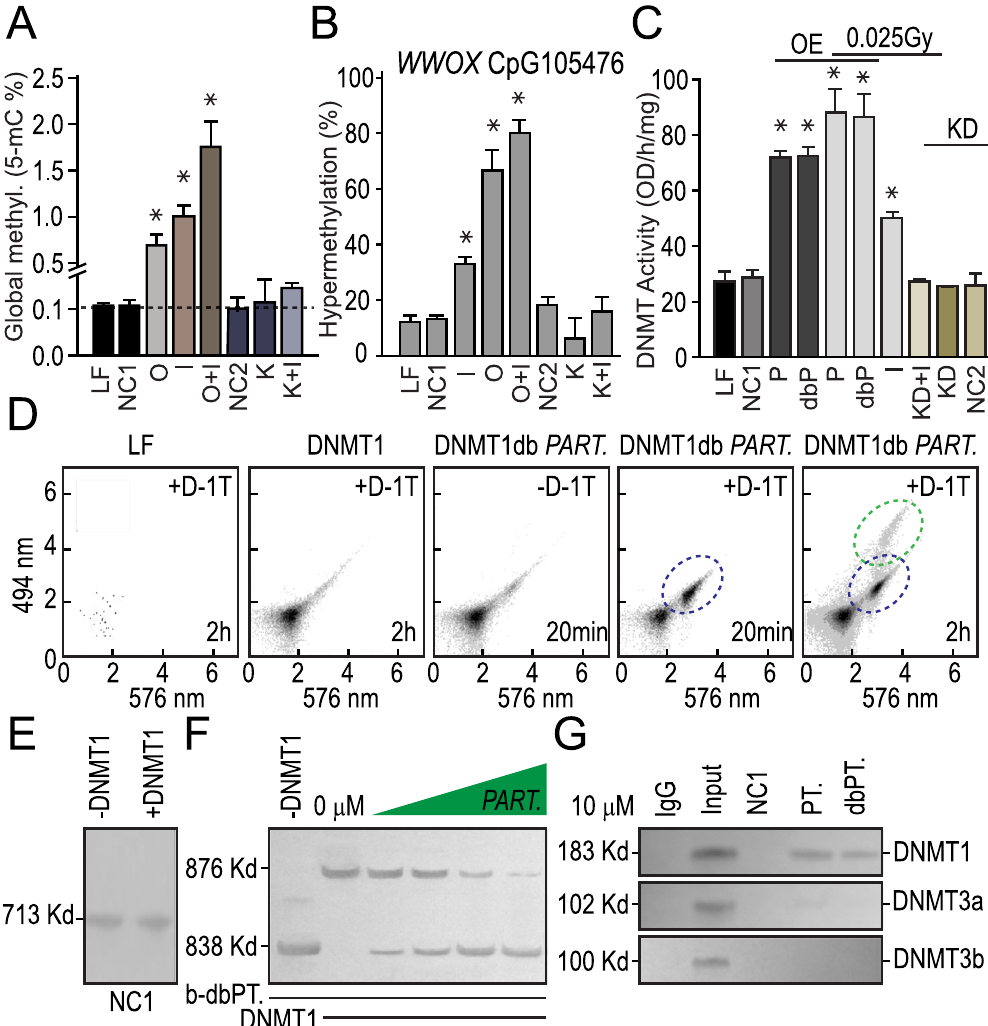
Figure 4. PARTICLE is implicated in global methylome enhancement, WWOX CpG island methylation and enzyme activity via DNMT1 interaction. ( A ) Histograms of global methylome percentage (5-mC ng/100ng genomic DNA input) from MDA-MD-361 post 24 hr sham irradiation lipofectamine control (LF) with PARTICLE over-expression (O) or knockdown (K) and/or 0.025 Gy exposure (I). ( B ) Histograms showing percentage hypermethylation of the CpG island within the WWOX promoter in MDA-MB-361 as indicated in (Fig. 2C) above. ( C ) Histograms showing DNMT activity in MDA-MB-361 (nomenclature as indicated in ( A ) above) and with PARTICLE (P) and dbroccoli- PARTICLE (dbP) overexpression. Data are represented as mean ± SEM (n = 3) and the asterisk(s) represent significant values (p < 0.05). ( D ) Flow cytometry scatter plots of MDA-MB-361 transfected with lipofectamine (LF), DNMT_RFP (DNMT1) and dbroccoli- PARTICLE in the absence or presence of DFHBI-1T (20 μ M). Time points since DFHBI-1T addition or comparative interval. ( E,F ) Representative nucleotide retardation gels (6%) of electrophoretic mobility shift assay involving binding reactions containing negative in vitro transcript control (NC1; E) or biotinylated dbroccoli - PARTICLE (b-db. PT ., 10 nM; F), ± human DNMT1 peptide (2.5 μ M) and increasing concentrations of unlabeled PARTICLE . ( G ) PARTICLE ( PT .) or dbroccoli- PARTICLE ( dbPT .) pulldown in U2OS and immunodetection with anti-DNA methyltransferases. ( E,G ) Cropped images of gels